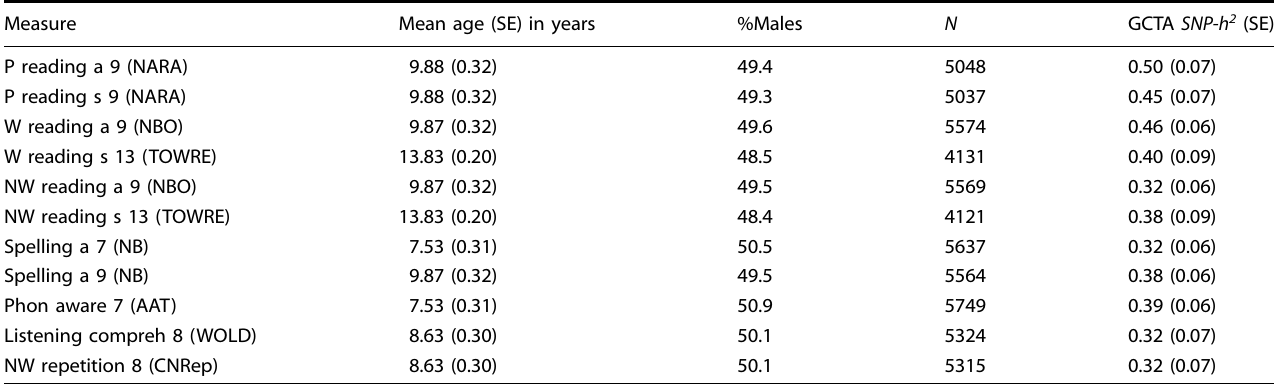
Table 1. Description of